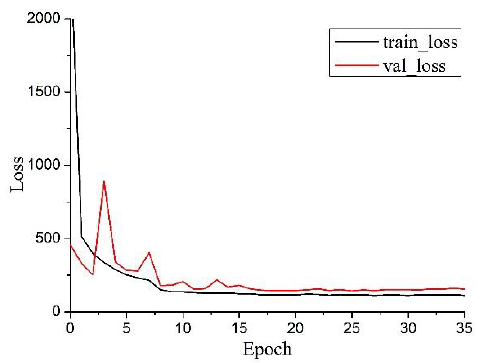
Figure 13. BP network convergence of the loss functions of RMSProp optimizer.